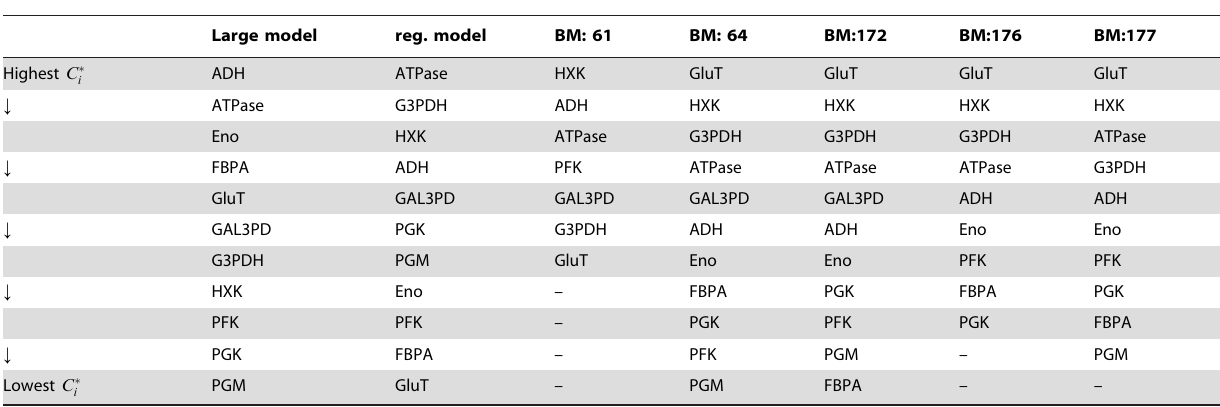
Table 1. Overall flux control exerted by different enzymes in